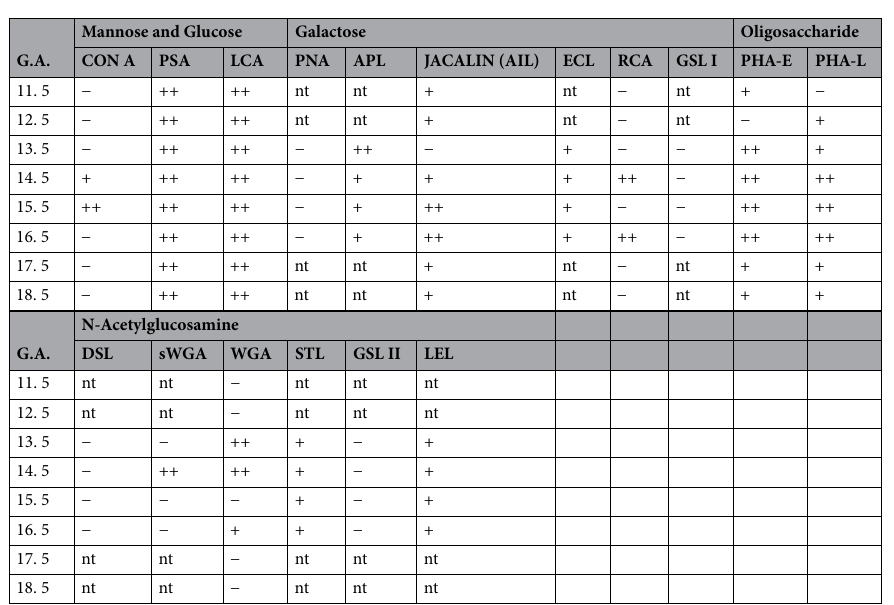
Table 2. Semi quantitative estimation of glycan expression through lectin labeling in megakaryocytes: Legend: G.A. gestational age. (+) expressed, (++) intensely expressed, (−) not expressed, nt not detected.